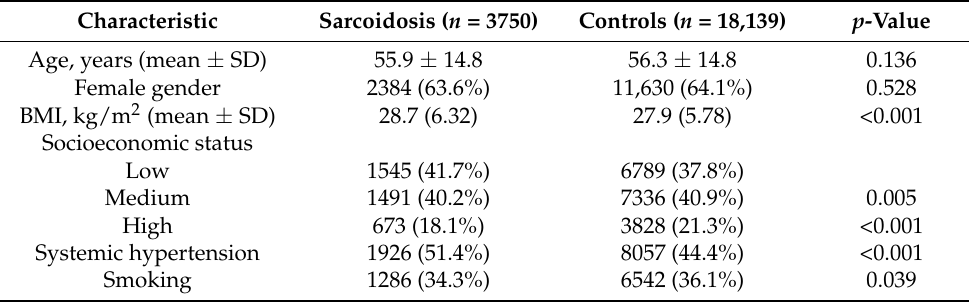
Table 2. Logistic regression for covariates associated with ischemic heart